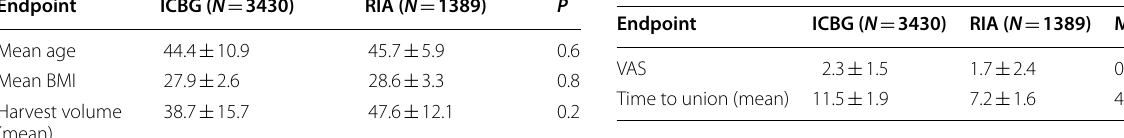
Table 4 Comparison of VAS and mean time to union